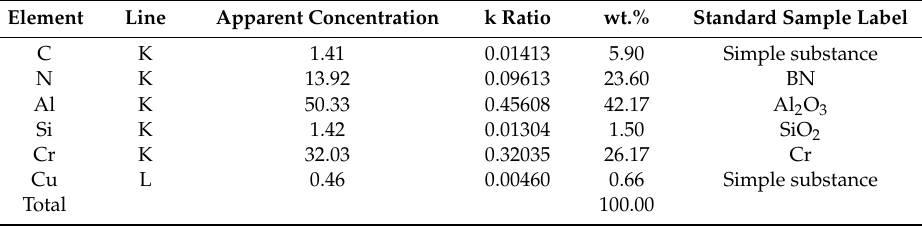
Figure 12. The X-ray diffraction spectrum of the AOF and the DLC film. Table 4. Variable pressure ratio experimental operation